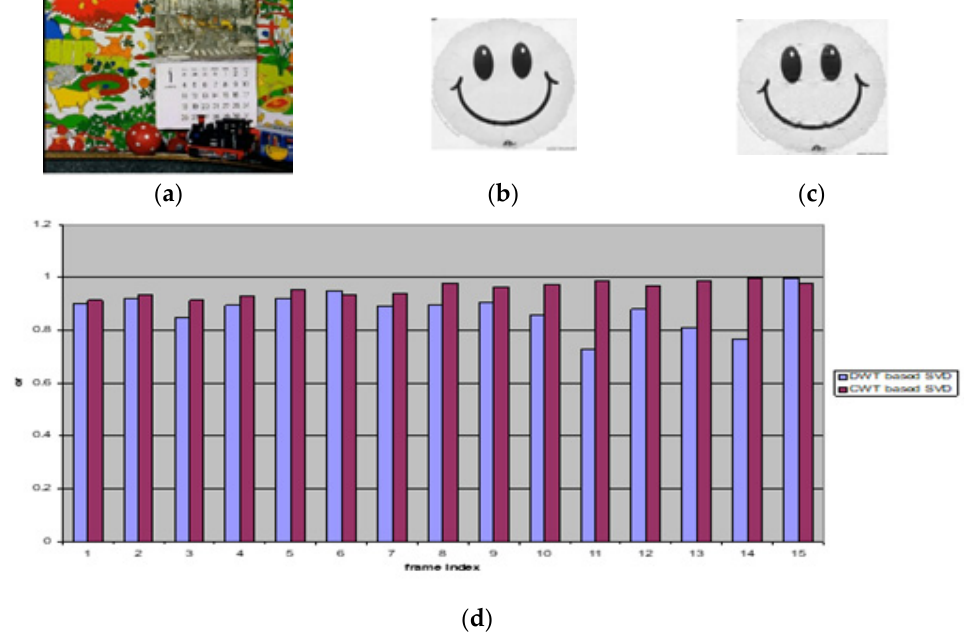
Figure 10. ( a ) The watermarked frame using the proposed method. ( b ) Extracted watermark from frame 10 of the second video in the proposed method. ( c ) Extracted watermark from frame 10 of the second video scene in the DWT-based SVD method. ( d ) Correlation values due to detected water- marks from each frame in the second video scene without attack.